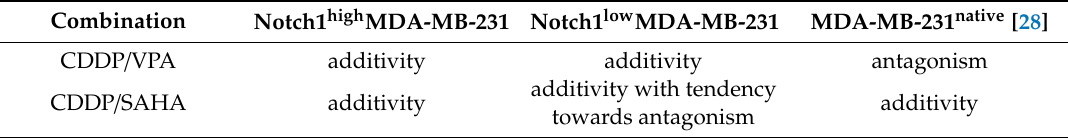
Table 3. Types of interactions between CDDP and SAHA or VPA at the fixed-ratio combination of 1:1 in MDA-MB-231 cancer cell lines with increased (Notch1 high MDA-MB-231) or decreased (Notch1 low MDA-MB-231) activity of Notch1 with reference to MDA-MB-231 breast cancer cells with native level of Notch1 activity (MDA-MB-231 native ) [28] measured in vitro by the MTT assay.